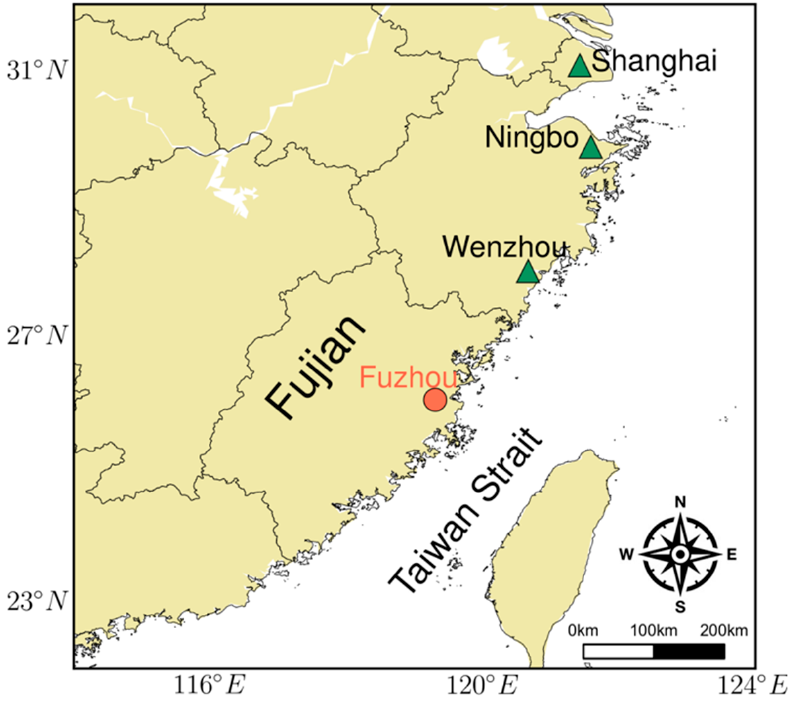
Figure 1. Red dot marks the location of Fuzhou in southeastern China. Green triangles mark the locations of three upwind cities: Shanghai, Ningbo, and Wenzhou.